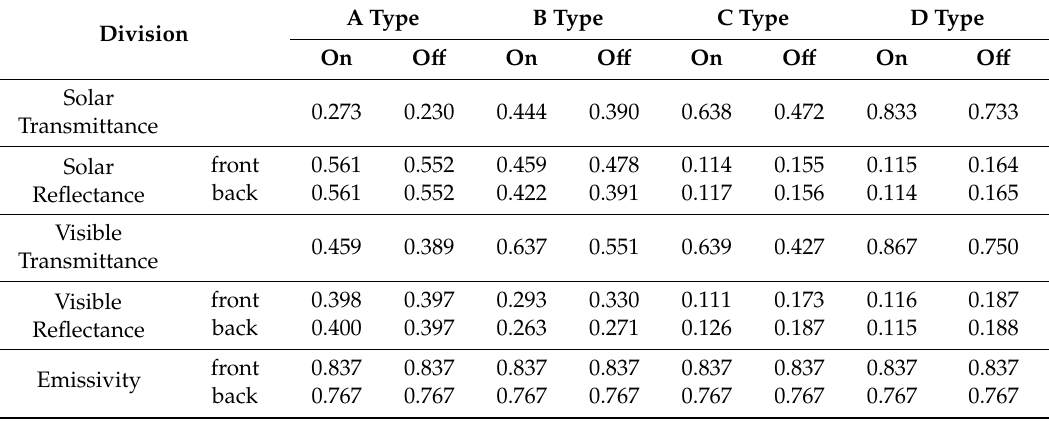
Table 1. Optical properties data by PDLC film type derived using Lawrence Berkeley National Laboratory (LBNL) Optic 6